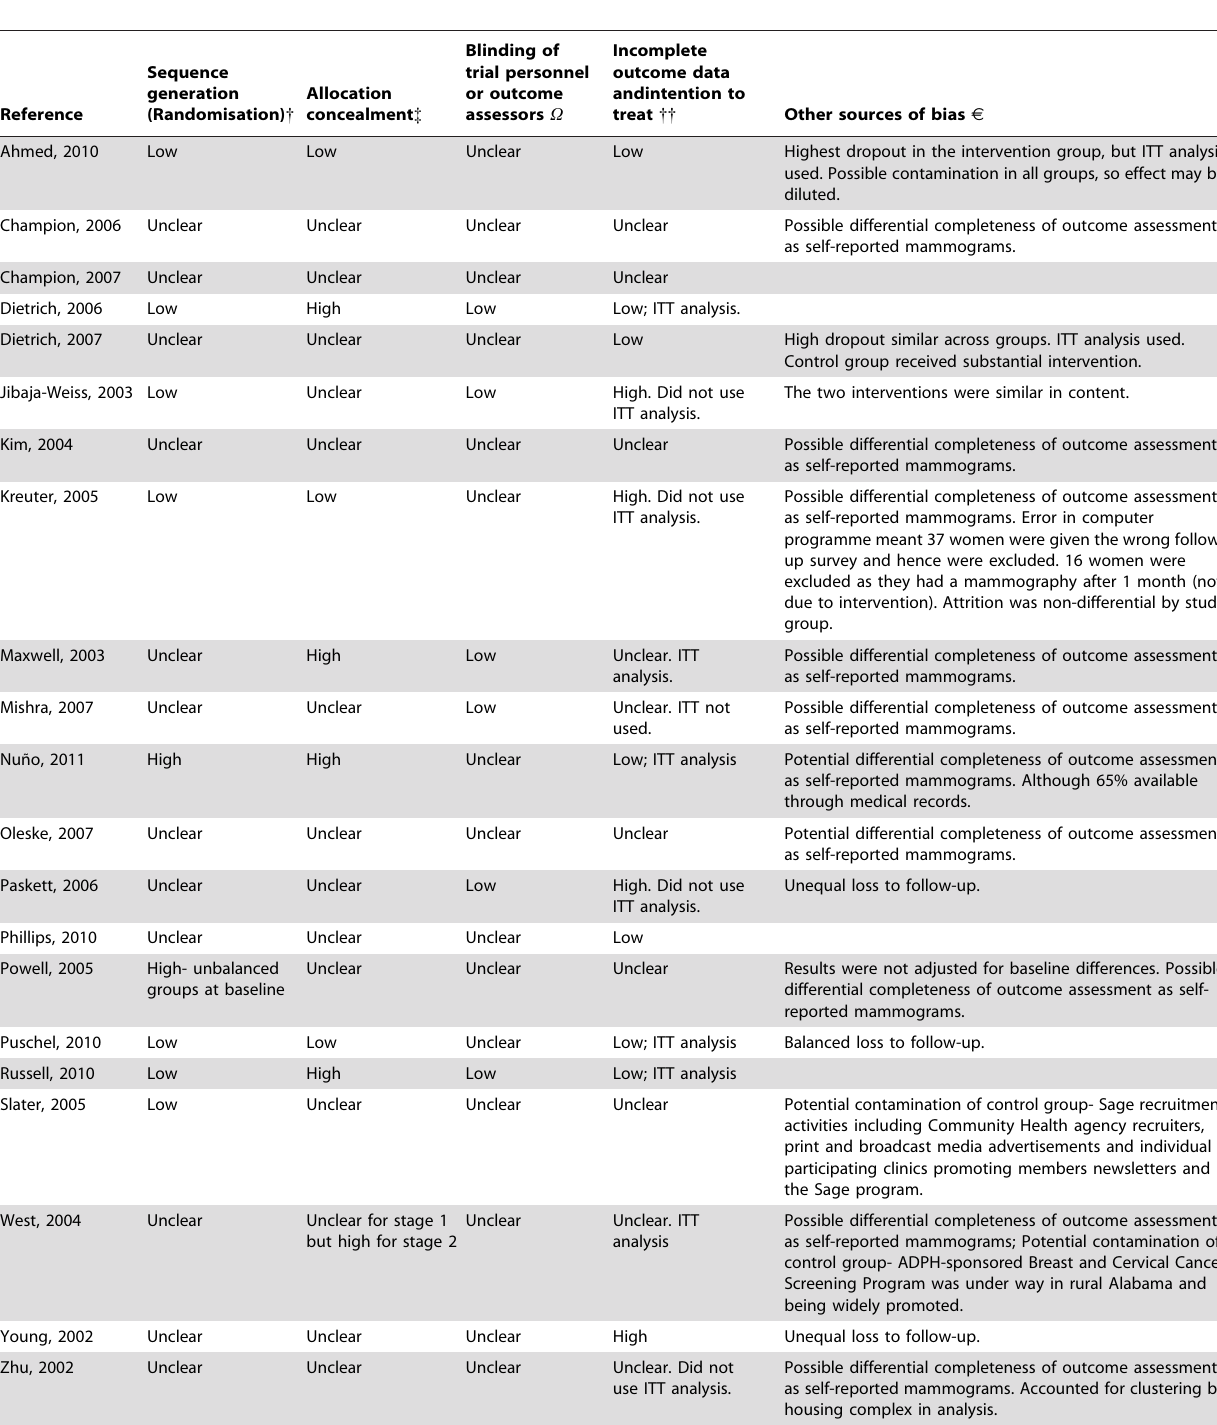
Table 5. Risk of bias*